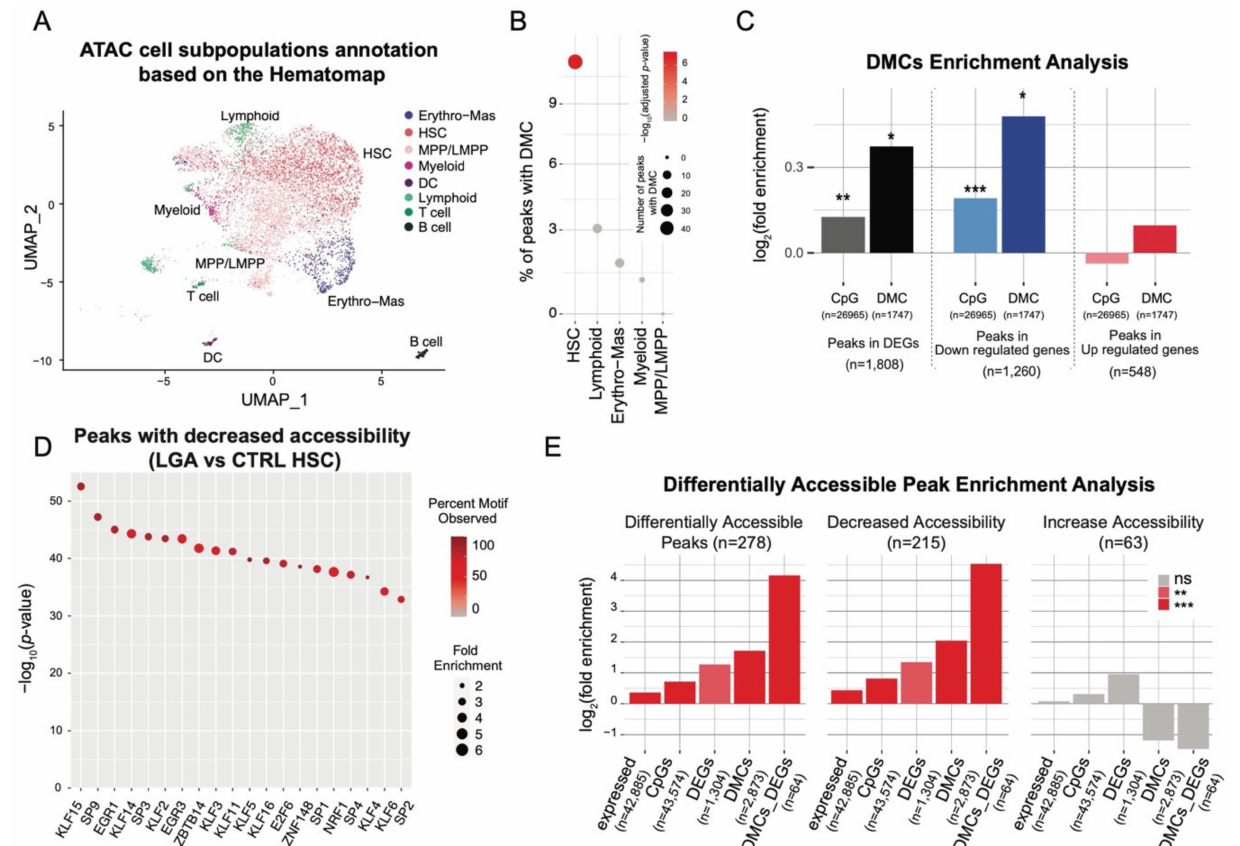
Figure 4. Chromatin accessibility analysis. ( A ) UMAP representing HSPCs lineage based on chro- matin accessibility. Annotations are based on the Hematomap using the transfer label approach. ( B ) Dot plot representing enrichment for DMC within lineage-specific peaks. ( C ) Bar plots represent- ing enrichment for peaks containing CpG or peaks containing DMC associated to DEGs, up-regulated and down-regulated genes (* p -value < 0.05; ** p -value < 0.01, *** p -value < 0.001, hypergeometric test). ( D ) Dot plot representing enrichment for transcription factor motif within Down peaks iden- tified comparing chromatin accessibility between LGA and CTRL. Dots are color-coded based on percentage of peaks with motif and y-axis represents the significance of the enrichment. ( E ) Bar plots representing enrichment analysis considering accessible, down, and up peaks. Enrichment is performed using peaks in expressed genes (expressed), peaks with CpGs (CpGs), peaks in DEG (DEGs), peaks with DMC (DMCs), and peaks in DEG with DMC (DMCs_DEGs) as reference